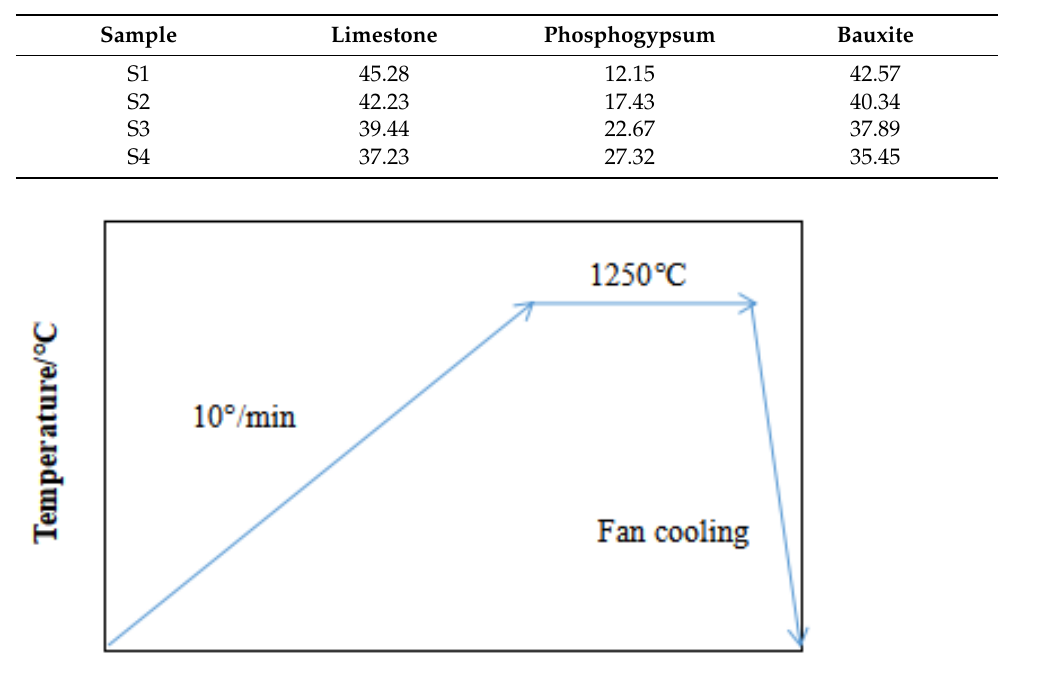
Figure 3. Cement clinker firing process.